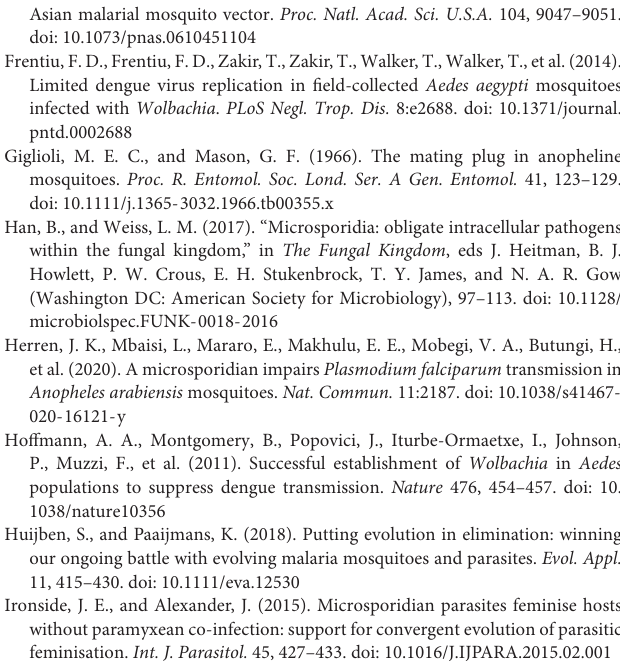
Supplementary Figure 1 | The intensity of Microsporidia MB in recipient females is not correlated to donor male intensity, with a regression slope that does not significantly differ from zero ( P = 0.34, r = 0.177, and n =